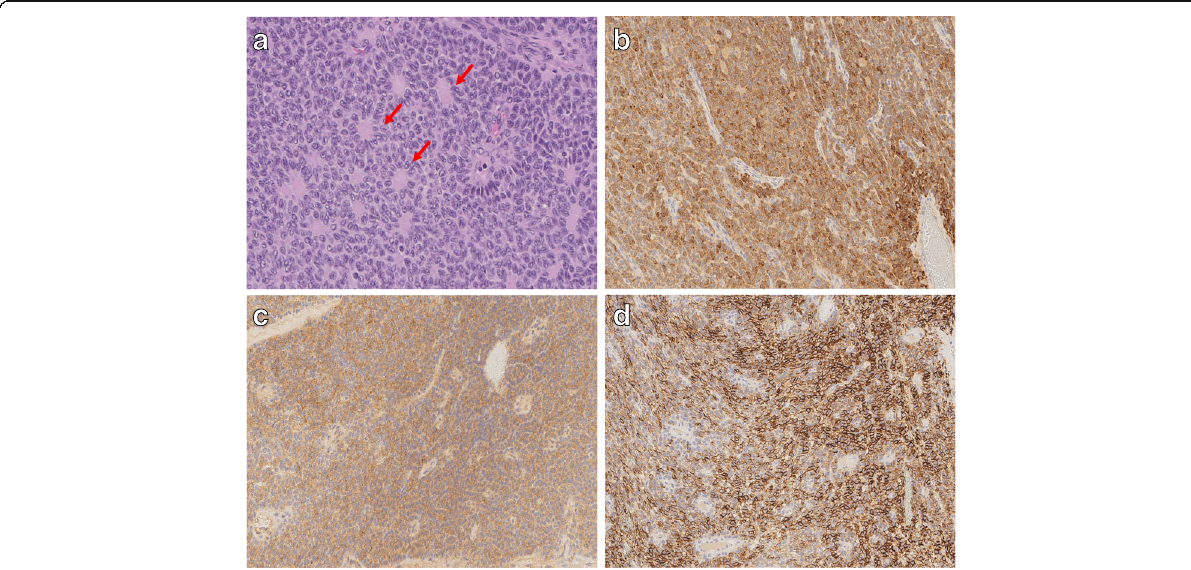
Fig. 4 Immunohistochemical results. a Hematoxylin and eosin-stained image shows an acidophilic non-structural substance (Call-Exner body) in the center of the rosette-like structure (red arrow) and a “ coffee bean-like ” nuclear groove. Immunostaining is also performed for b inhibin- α (× 20), c CD99 (× 20), and d CD56 (× 20)